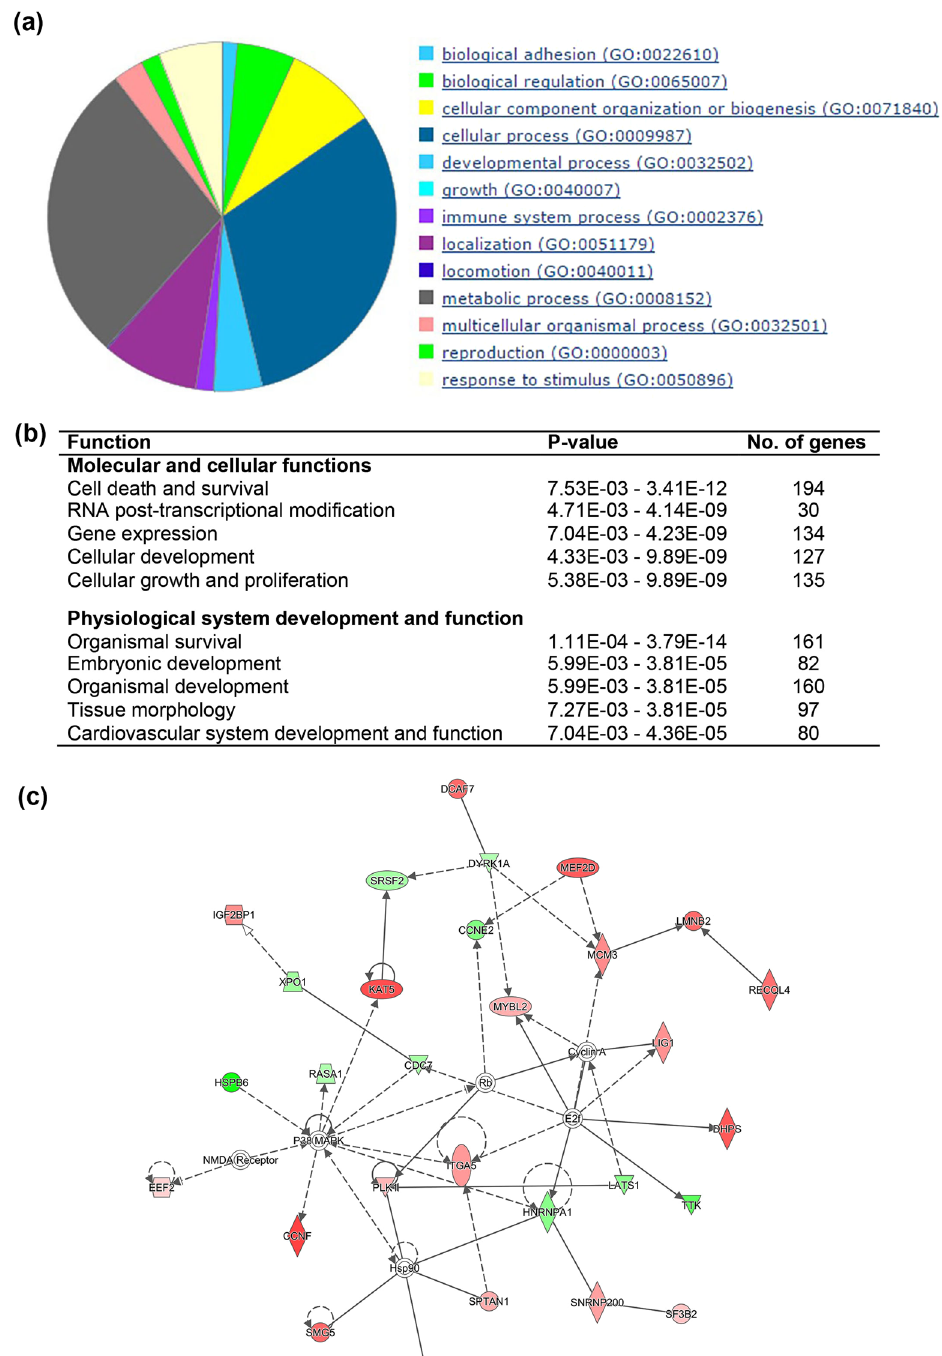
Figure 5. Effects of mtDNA supplementation alone on gene expression of miNT embryos when compared with SCNT blastocysts derived from depleted cells cultured in the presence of TSA (n = 3 to 4/group). ( a ) PANTHER biological process classification. ( b ) List of the top five biological functions. ( c ) Gene interaction network involved in cell cycle, cell death and survival, and DNA replication, recombination, and repair. Upregulated and downregulated genes are represented in red and green, respectively. The intensity of colour represents the degree of regulation. Colourless or grey nodes are genes involved in the network which were obtained from the Ingenuity Knowledge Base. The solid and dashed lines represent direct and indirect interactions,